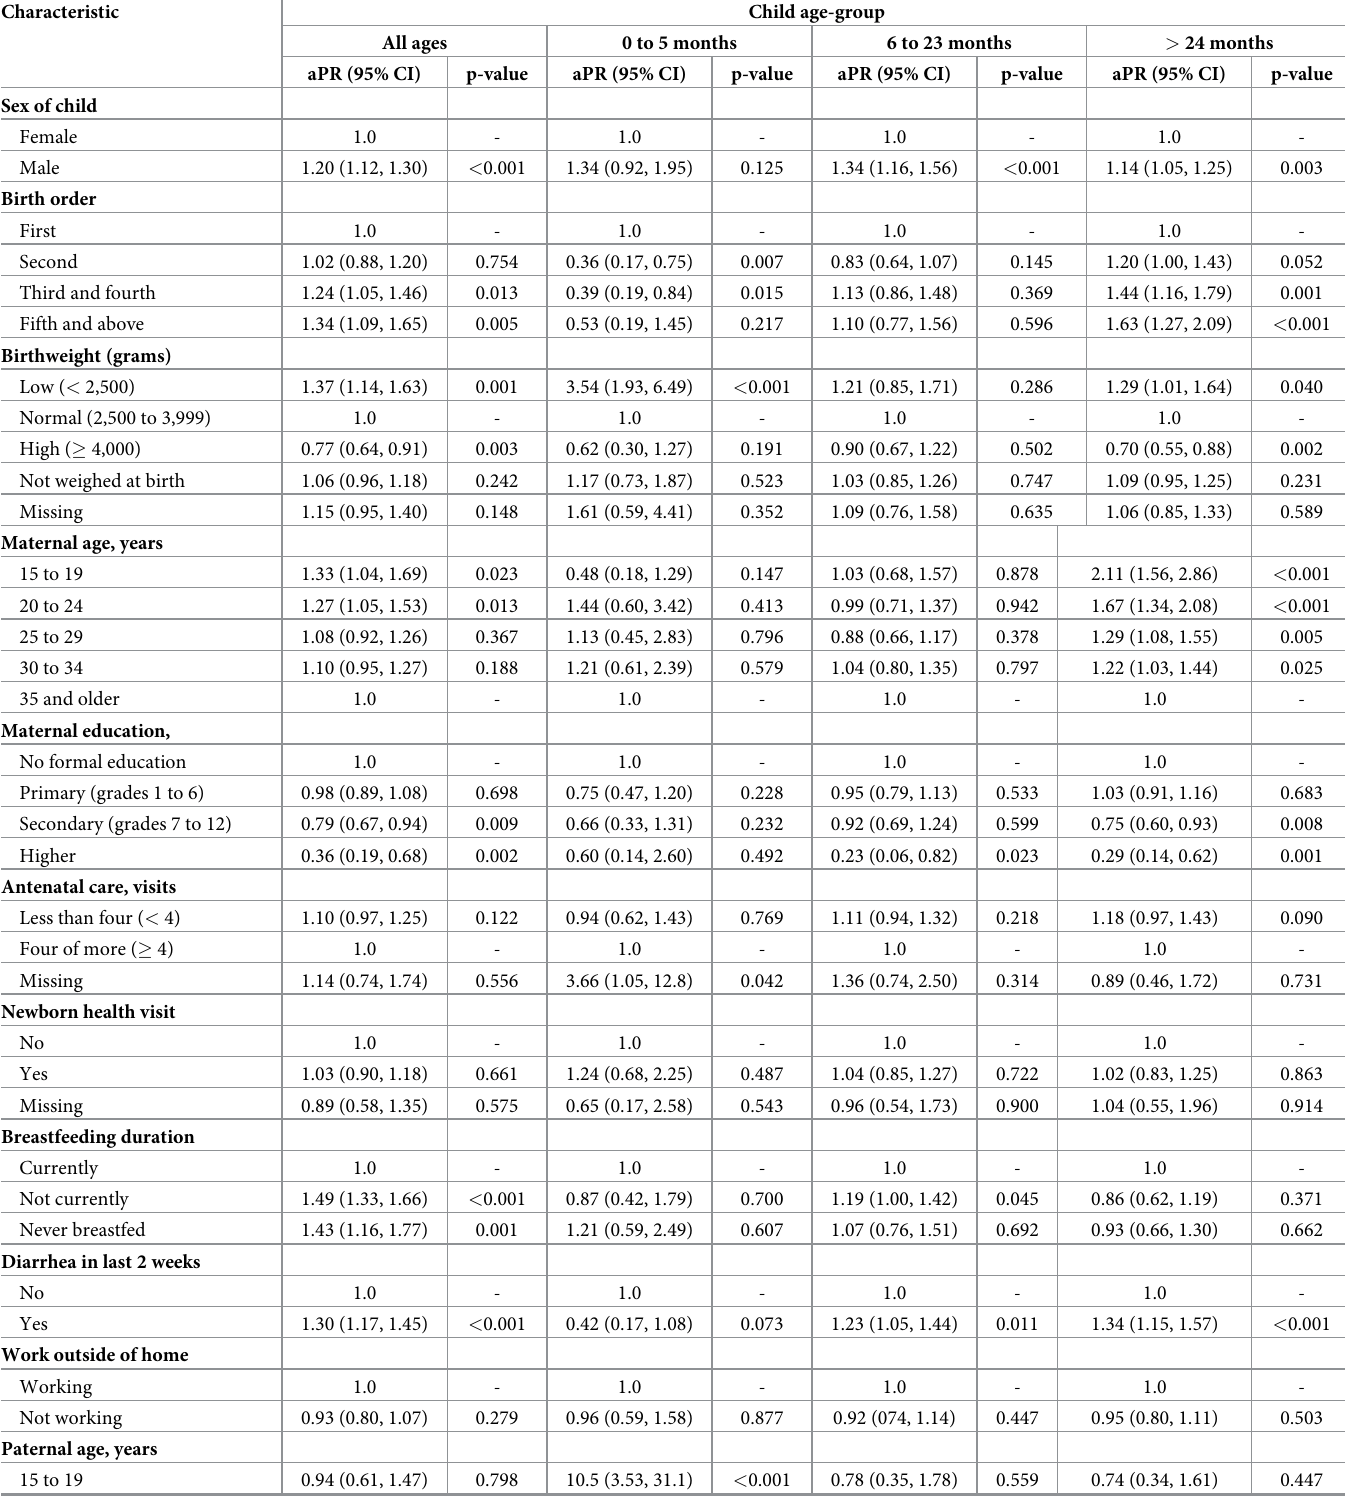
Table 3. Prevalence ratio adjusted for covariates (aPR), according to characteristics of participants and households stratified on child age-group.